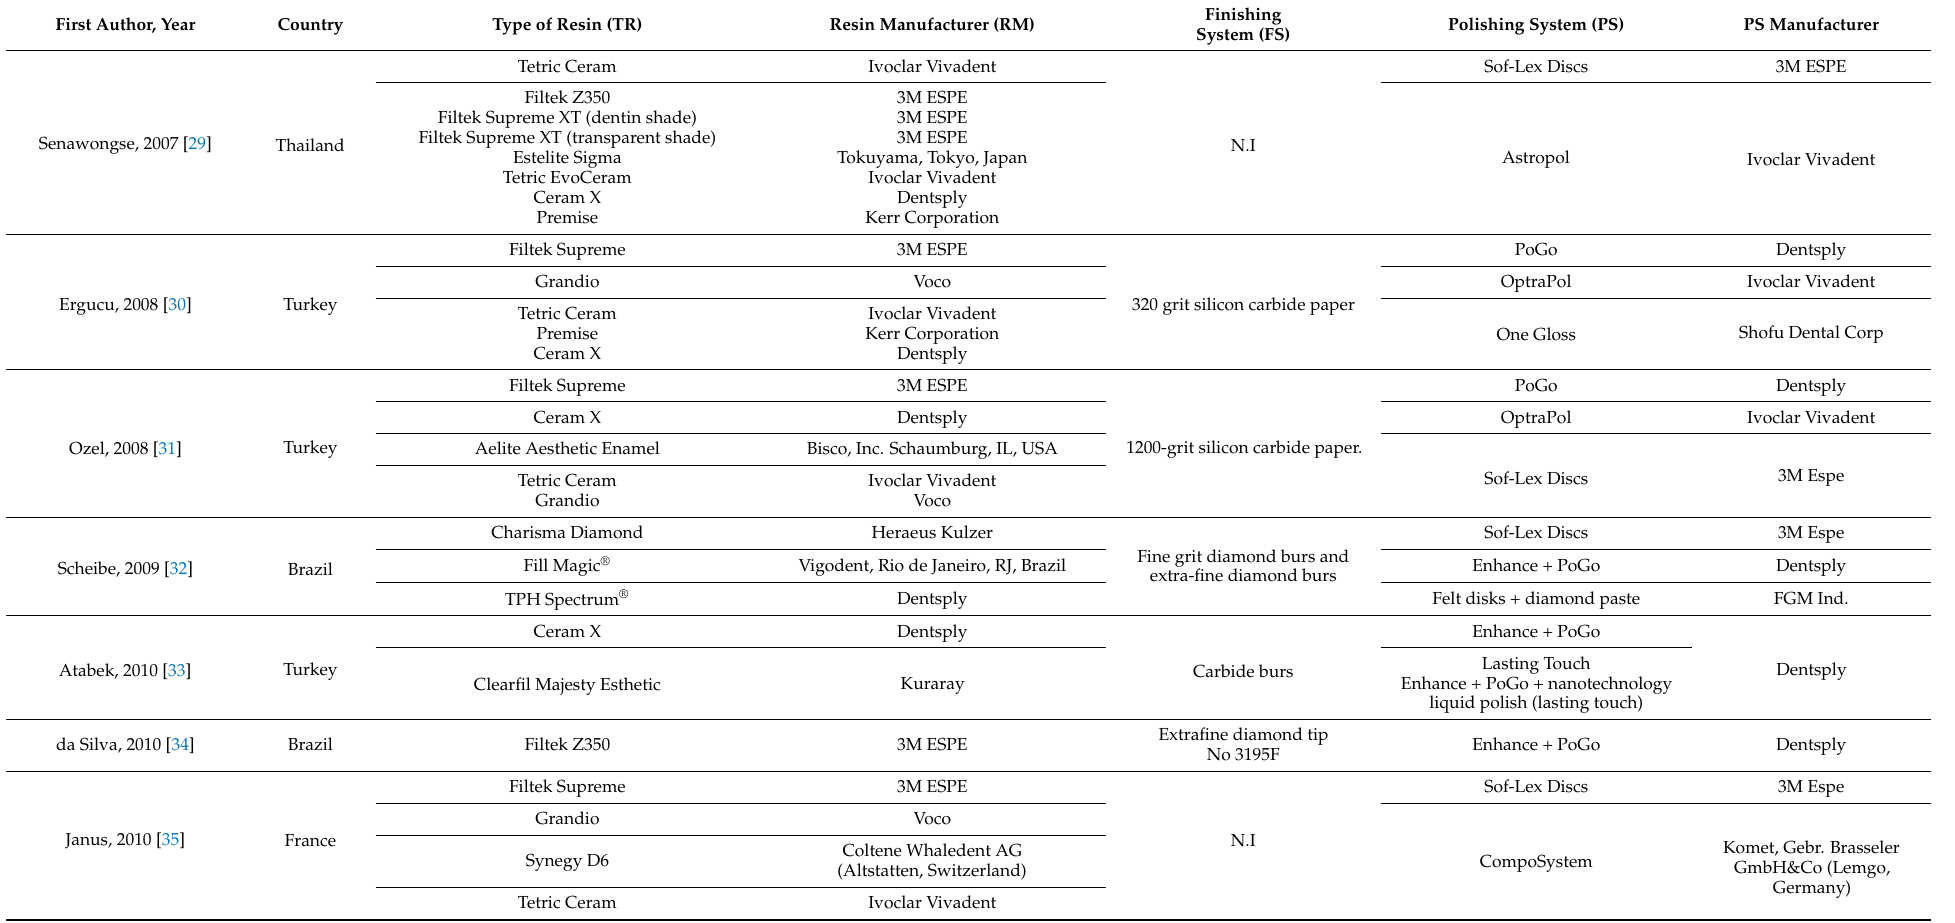
Table 2. Main characteristics of the studies included in the systematic review (n =